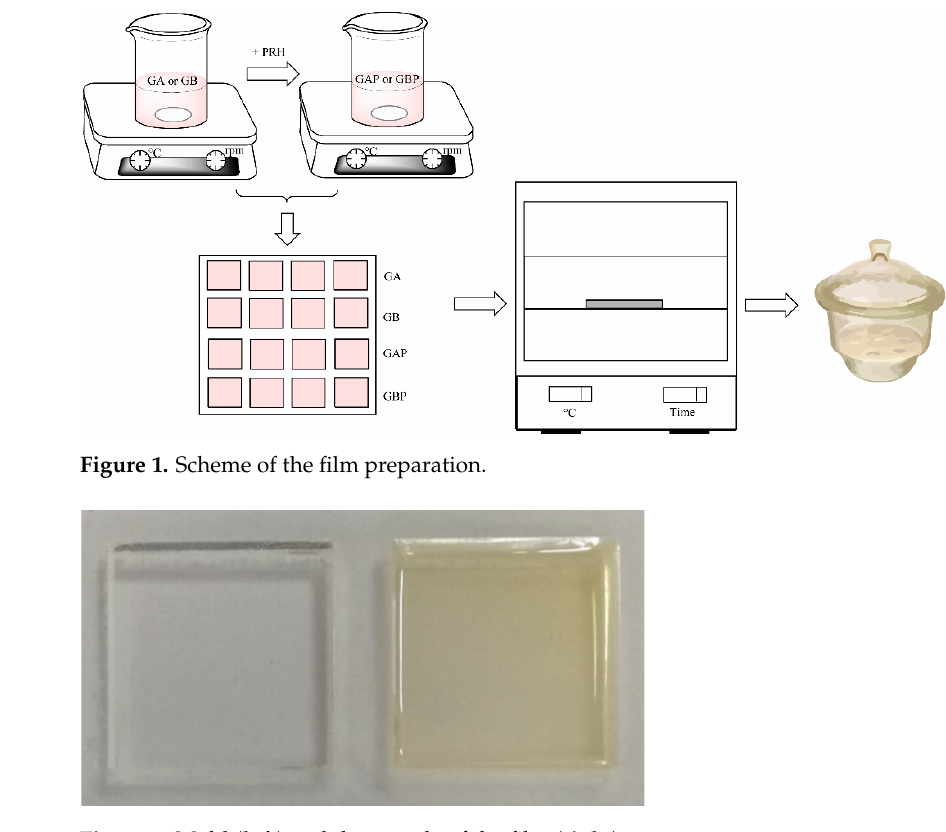
Figure 2. Mold ( left ) and the sample of the film ( right ).